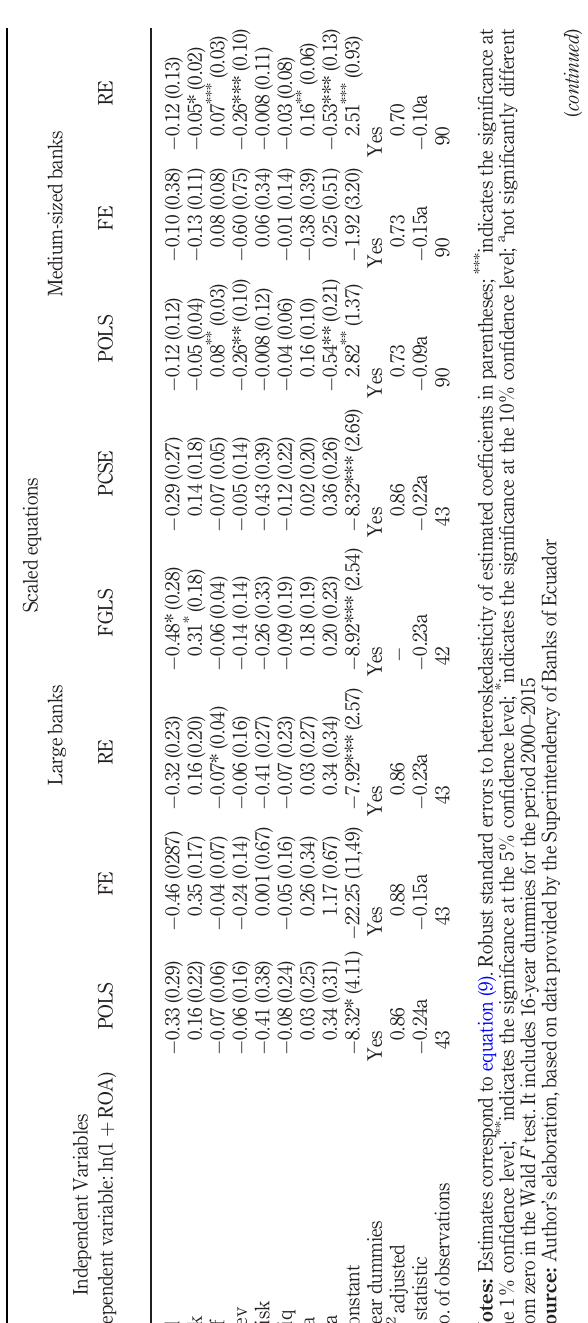
Table 8. Equilibrium